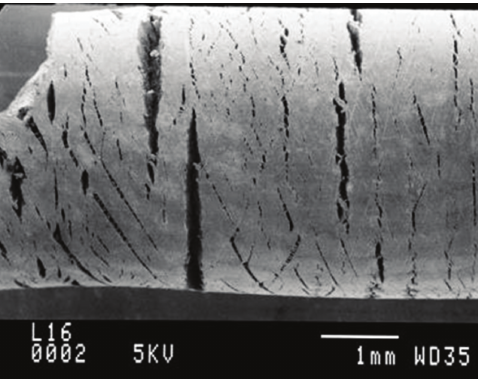
Figure 11: The influence of grinding marks on crack initiation for a slow strain-rate sample tested at 45 ◦ C and 800 kPa 25% CO–75% CO 2